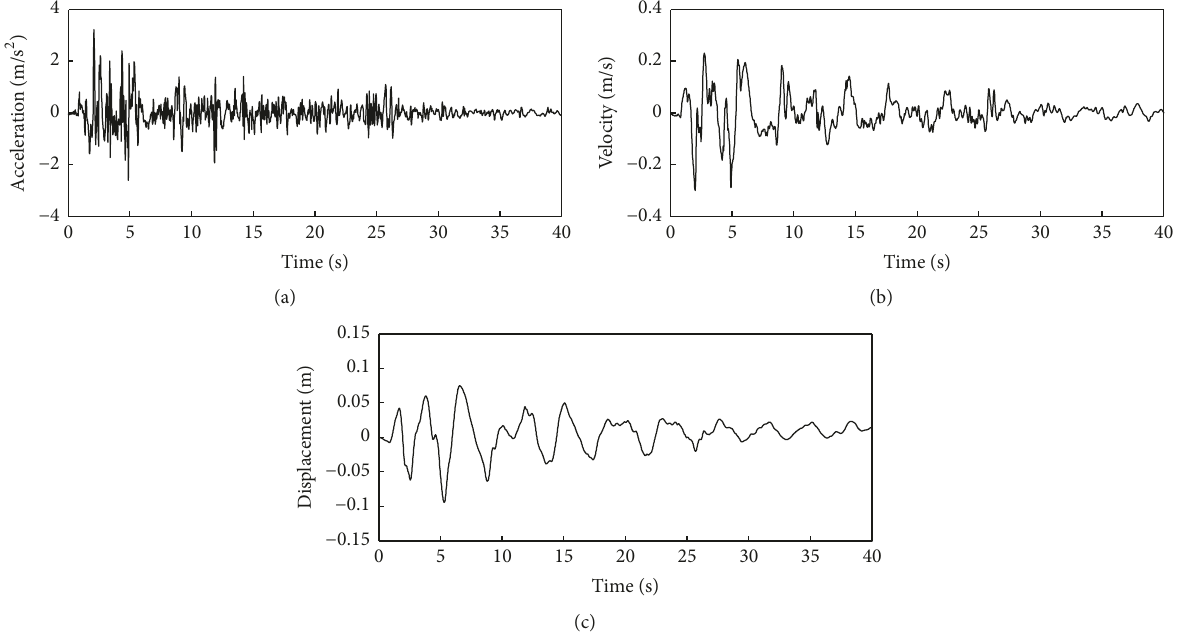
Figure 3: Simulated ground motion at station with 𝑟 𝑛 = 400 m: (a) acceleration; (b) velocity; (c)